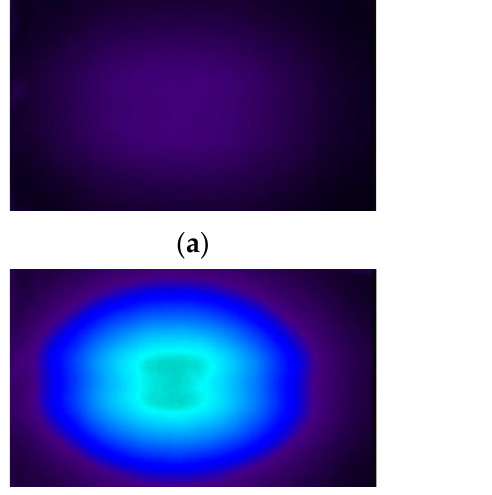
Figure 8. Laboratory-scale setup: temperature distribution on the sheet using a trough ceramic heater with 500 W maximum power consumption at ( a ) t = 15 s; ( b ) t = 30 s; ( c ) t = 45 s; ( d ) t = 60 s.